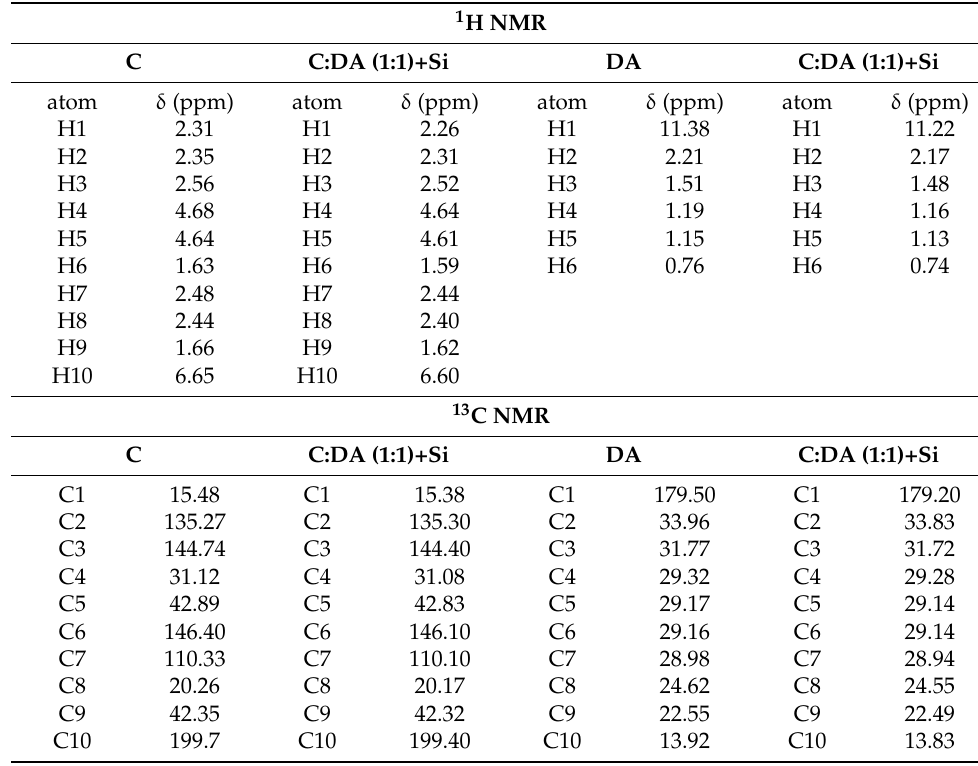
Table 2. Chemical shift values from 1 H NMR and 13 C NMR spectra from individual DES components before and after the siloxane absorption process.